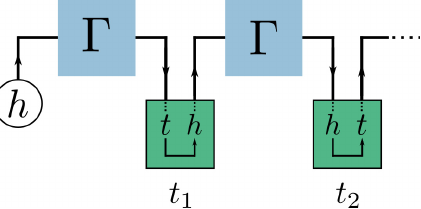
FIG. 13. Perturbed coin with interventions. Between measure- ments, the coin—which initially shows heads—is perturbed and stays on its side with probability p and flips with probability 1 − p , leading to a stochastic matrix (cid:5) between measurements. Using their instrument, upon measuring an outcome, the experimenter flips the coin. Here, this is shown for the sequence of outcomes th . For most values of the probability p , this process—despite being fully classical—does not satisfy the requirement of the